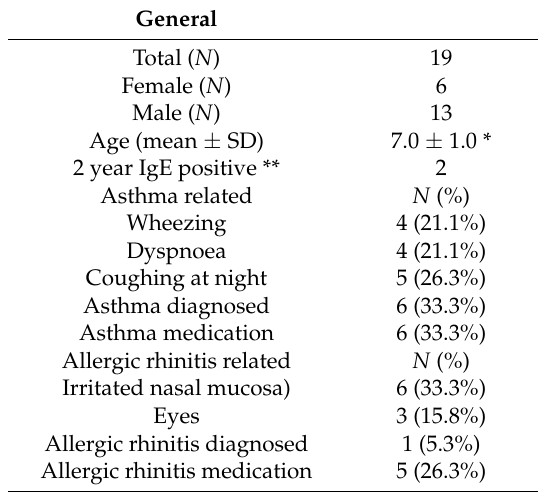
Figure 2. Polygenic risk scoring (weighted) for hypersensitive immune disorders asthma and autism spectrum disorder in relation to (prospectively obtained) hypersensitive immunological traits (Prism 5.01, 2007): (i) asthma related: wheezing; dyspnoe, (nightly) coughing; asthma clinically diagnosed; asthma medication (past 12 months), (ii) allergic rhinitis related: chronically irritated nasal mucosa, chronically irritated eyes, allergic rhinitis clinically diagnosed, Allergic rhinitis medication (past 12 months), (iii) atopic dermatitis: eczema; topical steroids use (past 12 months), (iiii) food allergy. ( A ) Asthma PRS scoring with (GWAS) cutoff of P T <0.001 and ( B ) asthma PRS scoring with (GWAS) cutoff of P T < 1. ( C ) ASD PRS scoring with (GWAS) cutoff of P T < 0.001 and ( D ) ASD PRS scoring with (GWAS) cutoff of P T < 0.01. ANOVA was performed to test for differences in means of the PRS between CMA patients scored for particular symptom or not. Red indicates no, green indicates yes. We assumed a P < 0.05 statistically significant. Table 3. Six year follow-up characteristics former CMA patients.